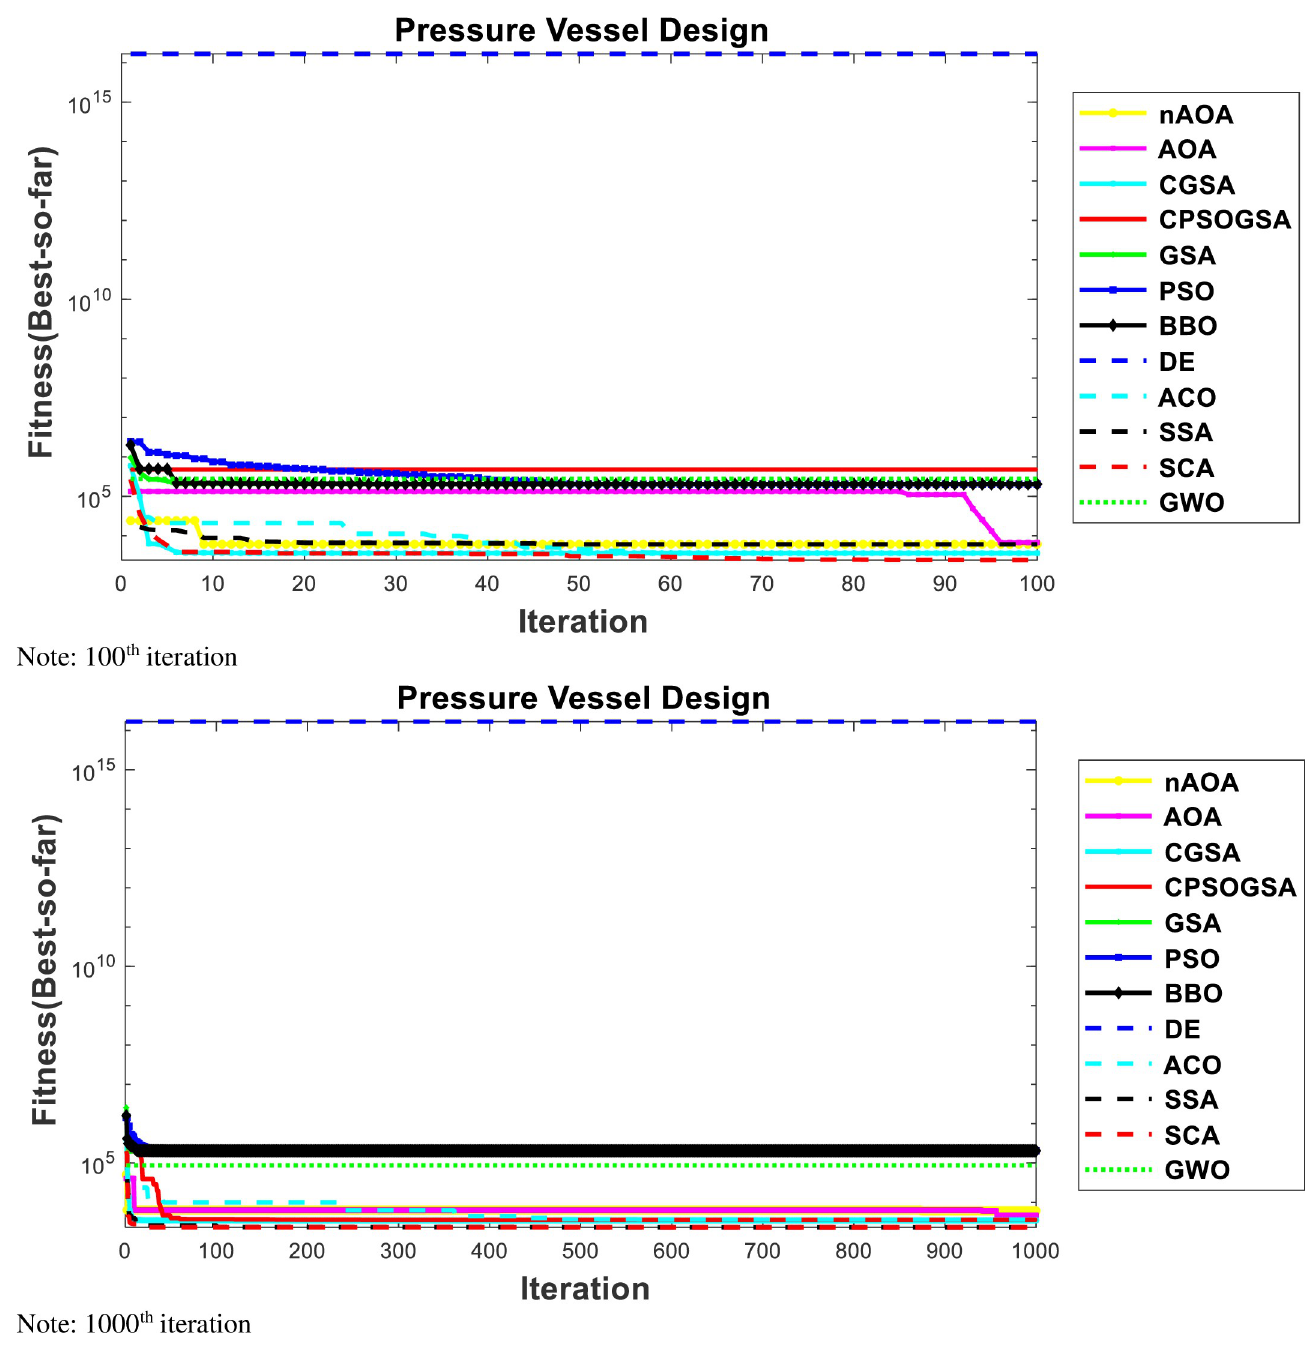
Fig 11. Convergence curves for PVD. Note: 100 th iteration. Note: 1000 th